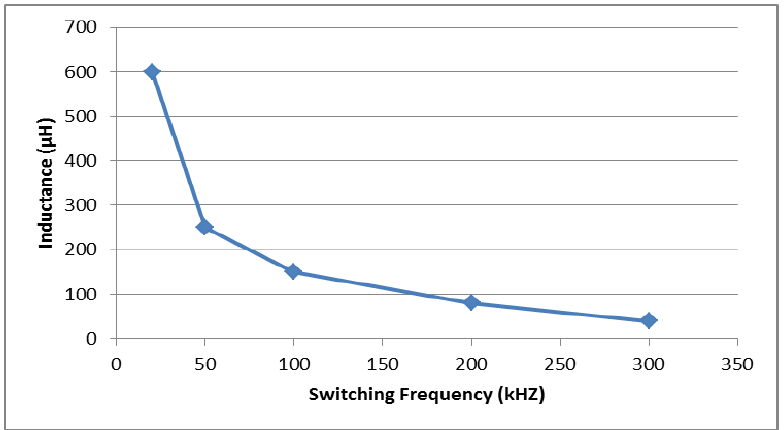
Figure 12. The effect of increasing the switching frequency on inductance size.